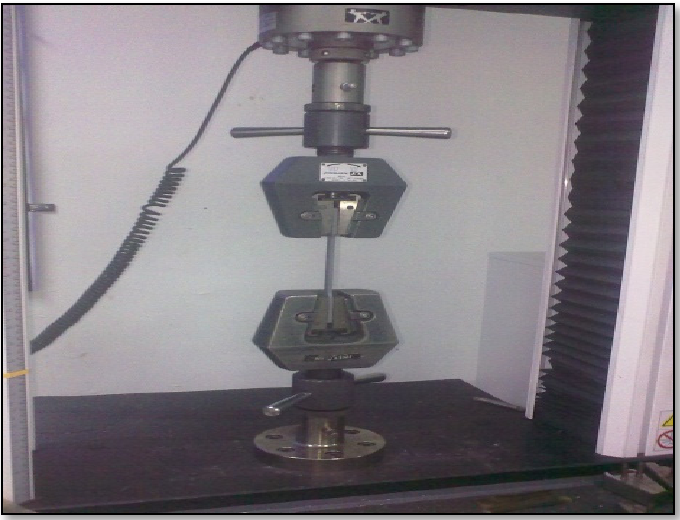
Figure 5. Tensile Testing Machine.